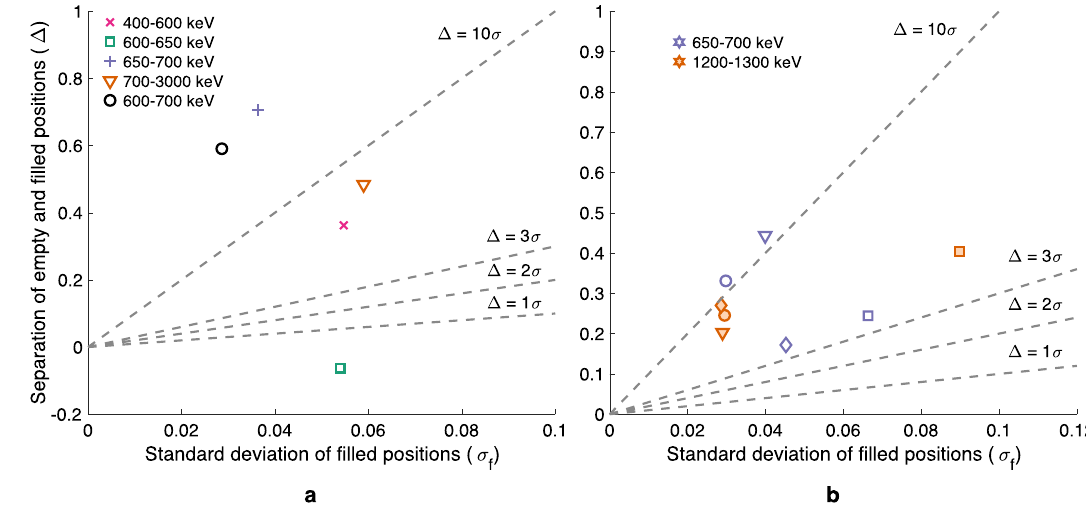
Figure 6. Image quality index plots for images from the Olkiluoto 2021 and Loviisa 2020 measurement campaign results. ( a ) Same Olkiluoto 2021 8 × 8 − 1 assembly as in Fig. 5 (BU 18.6 GWd/tU, CT 37 a). Results shown in five different gamma energy windows, denoted with varying colors and markers. ( b ) Four different VVER-440 assemblies from Loviisa 2021 campaign, both in the 650–700 keV window (orange) as well as the 1200–1300 keV window (violet). Each assembly has a unique symbol.